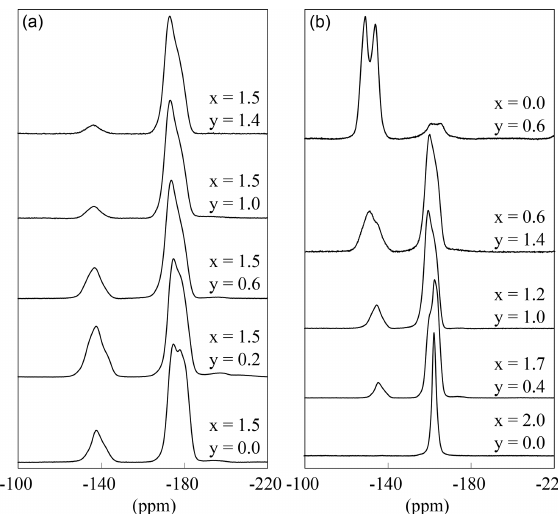
Figure 10. 19 F MAS NMR spectra of several samples with constant x = 1 . 5 content and increasing OH content (a) and with decreasing Li content (b)